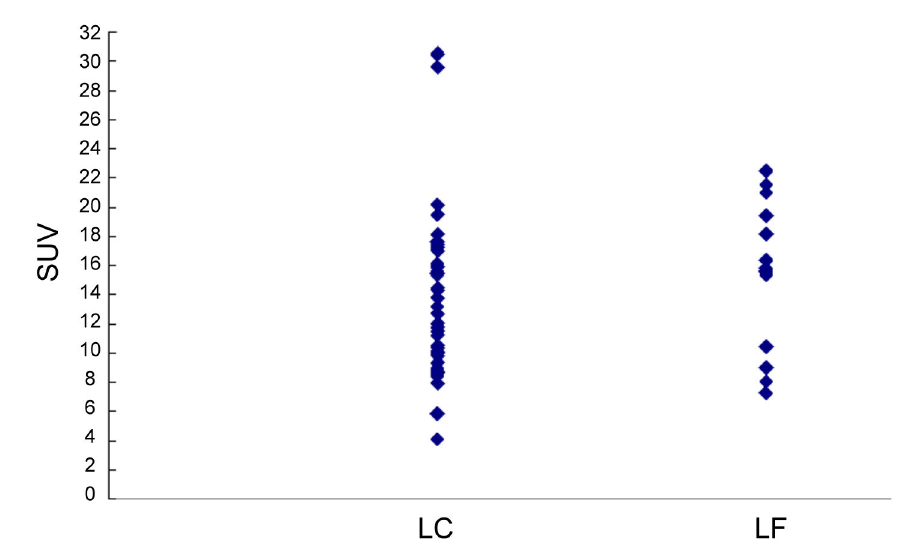
Figure 5. Scatterplots of SUV in the local control (LC, n = 41) and local failure (LR, n=17 ) groups. max